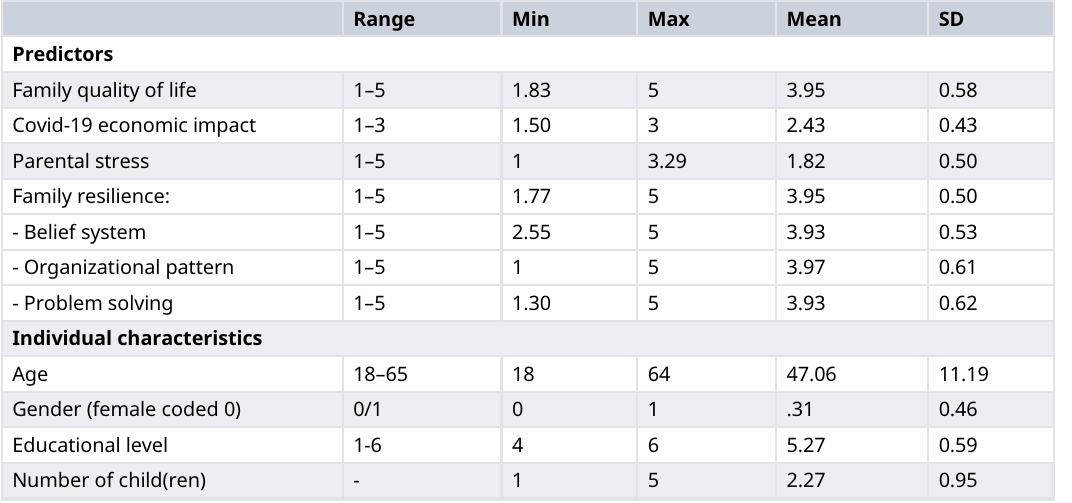
Table 1. Descriptive statistics of all variables.